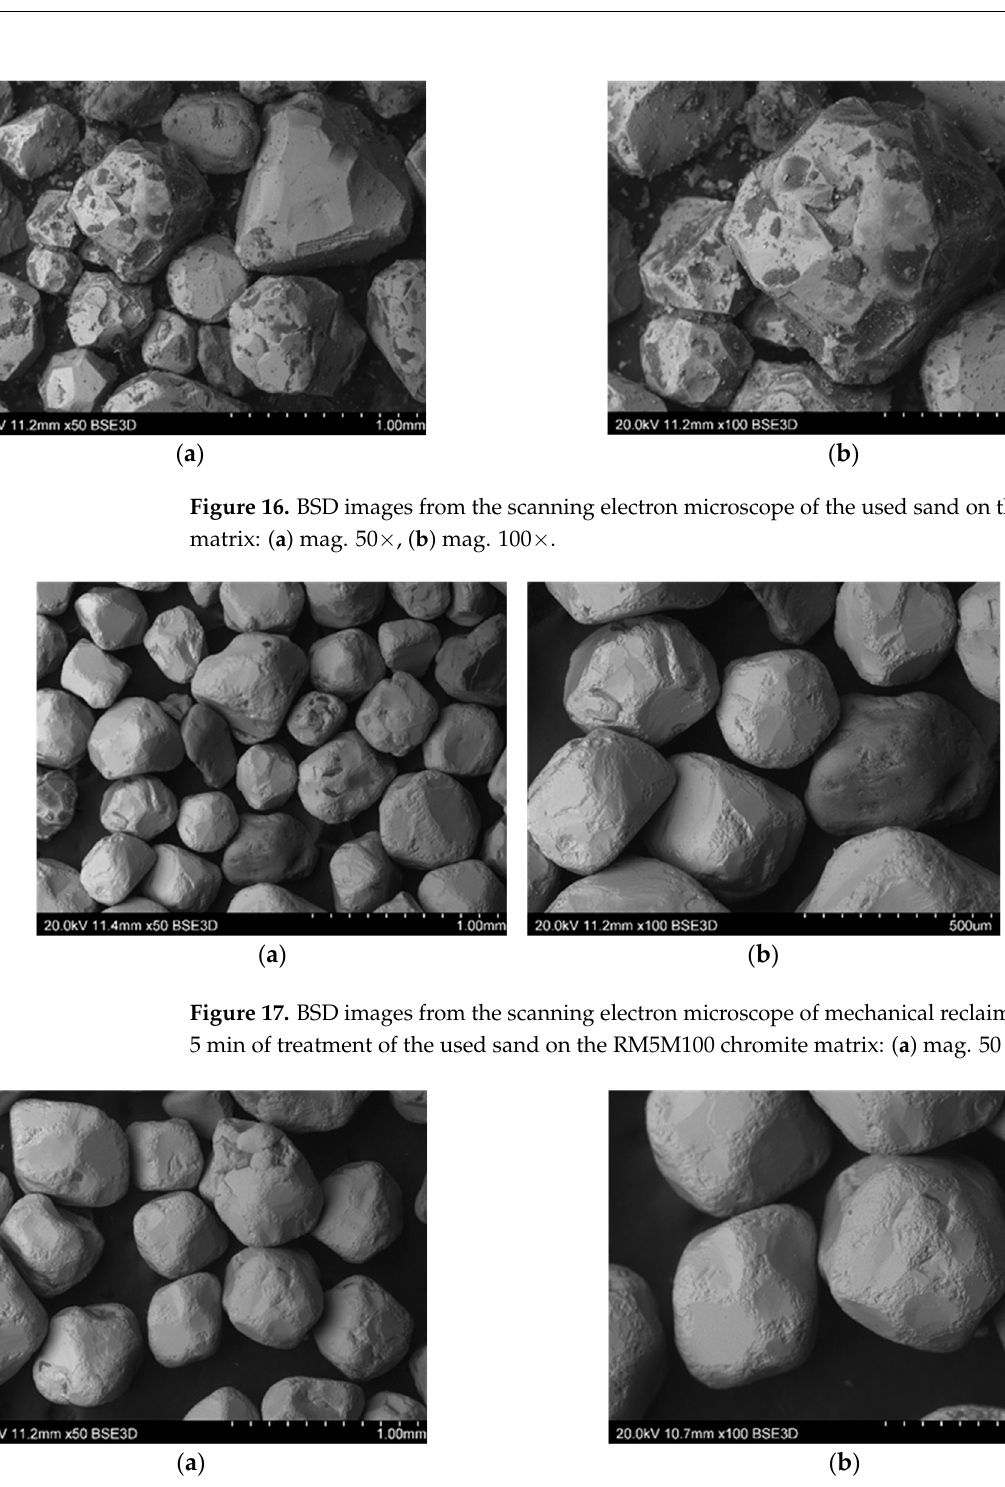
Figure 18. BSD images from the scanning electron microscope of mechanical reclaimed material after 15 min of treatment of the used sand on the RM10M100 chromite matrix: ( a ) mag. 50×, ( b ) mag. 100×.